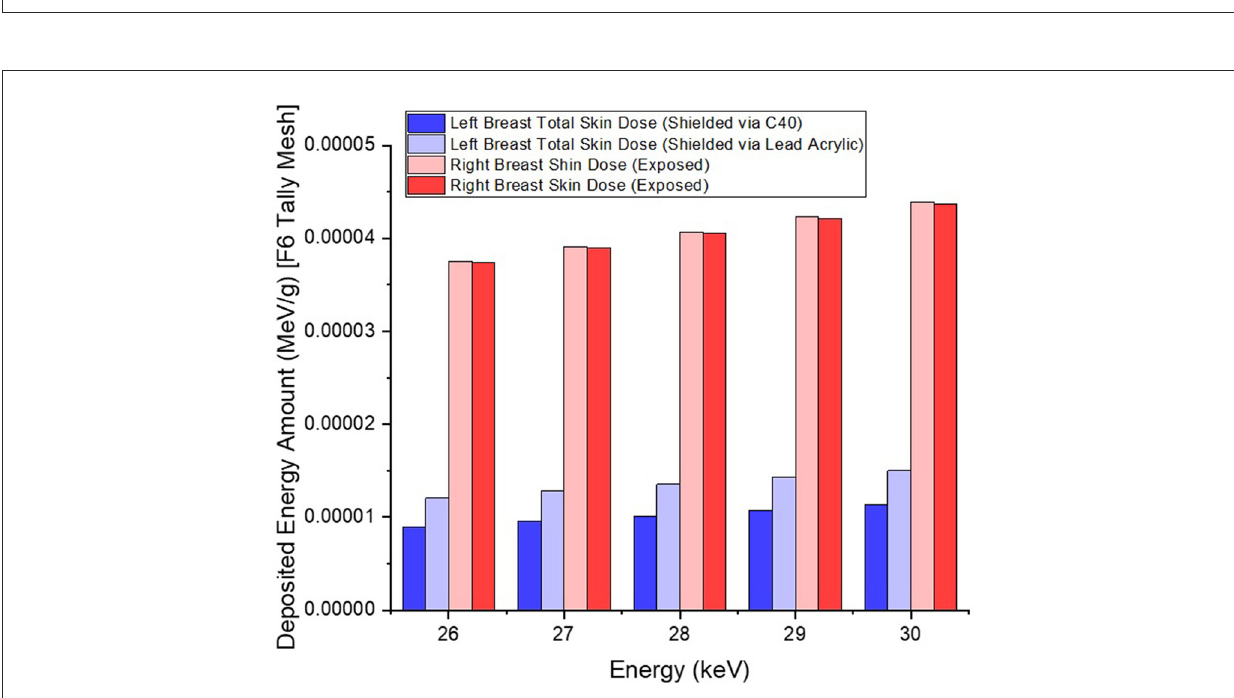
FIGURE8 Variation of total skin doses for left and right